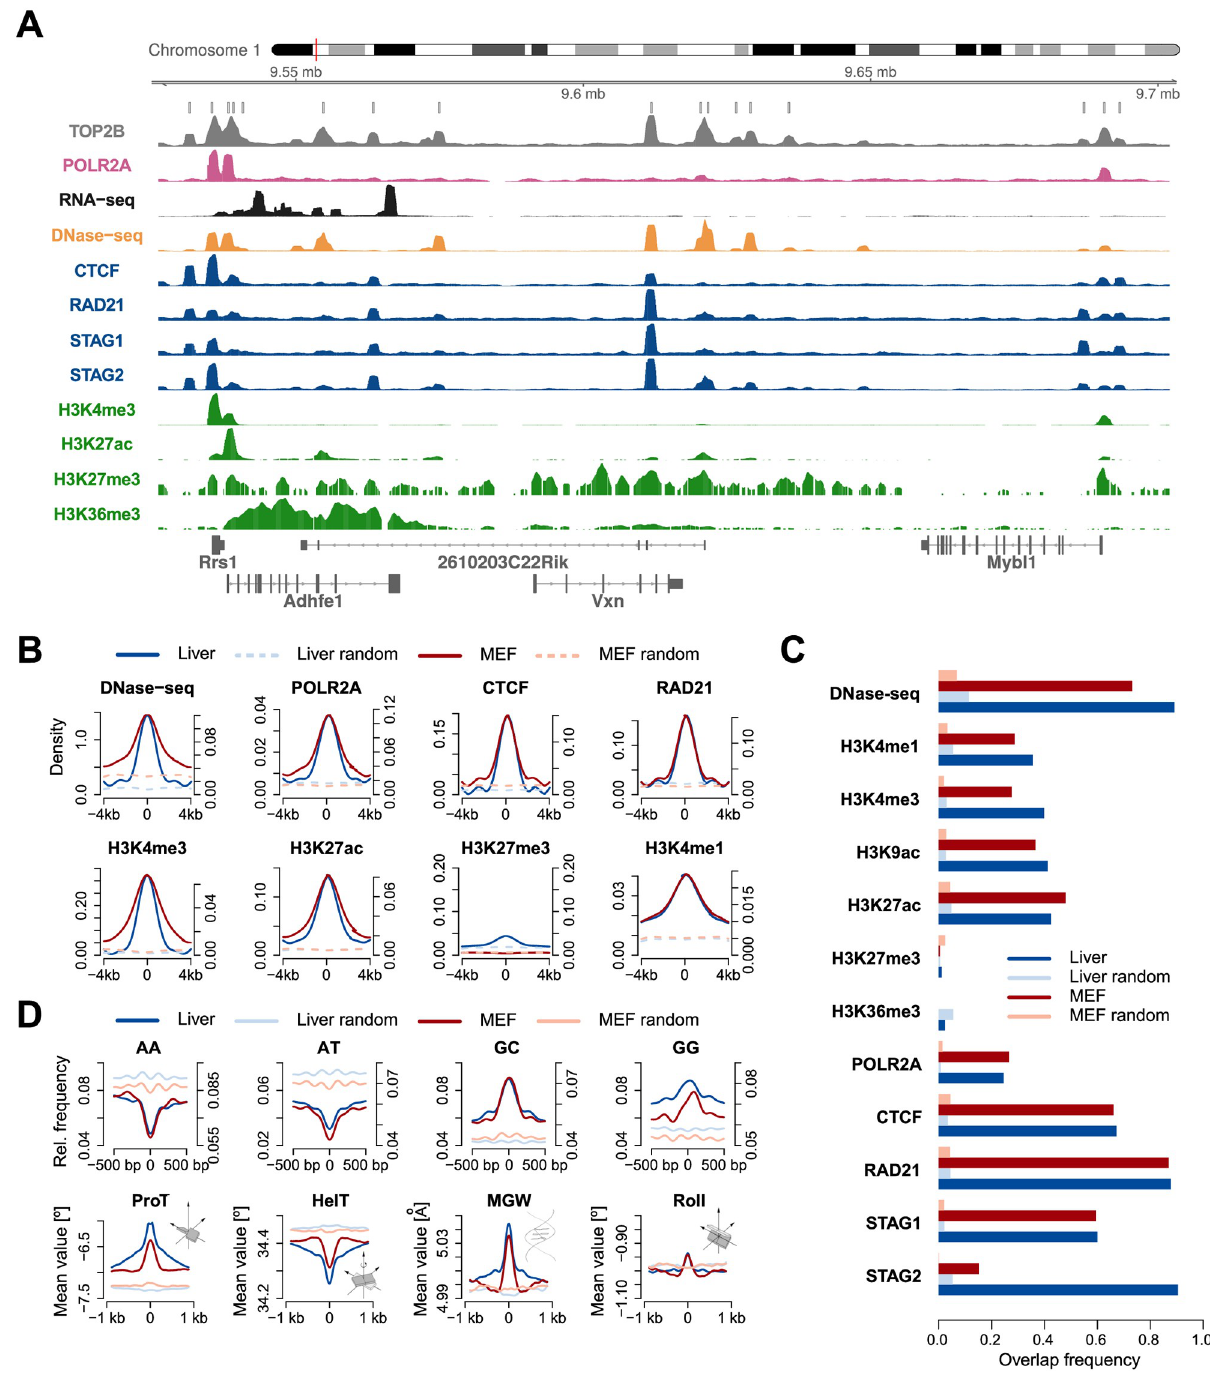
Fig 1. Chromatin landscape of TOP2B. A . Genome browser view for TOP2B ChIP-seq signal and other relevant chromatin features in mouse liver. B . Average reads enrichment of selected chromatin features within ± 4 kb of TOP2B binding center (solid lines) and random regions (dashed lines) in mouse liver (blue) and MEFs (red). Signals were smoothed using nucleR [50]. Left and right sided ordinate axes correspond to mouse liver and MEFs, respectively. C . Overlap frequencies of chromatin features at TOP2B binding sites as compared to random regions in mouse liver and MEFs. D . Top panel shows relative frequency of several dinucleotides within ± 500 bp of TOP2B binding center and random regions. Bottom panel shows average of 3D DNA shape features within ± 1 kb of TOP2B binding center and random regions. Profiles corresponding to MEFs and liver are colored as in C.